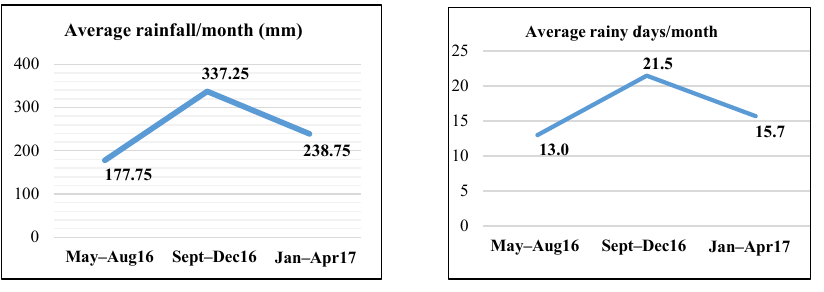
Figure 2 Average rainfall/month and average rainy days/month for each period of the year. May–Aug16 – May–August 2016;